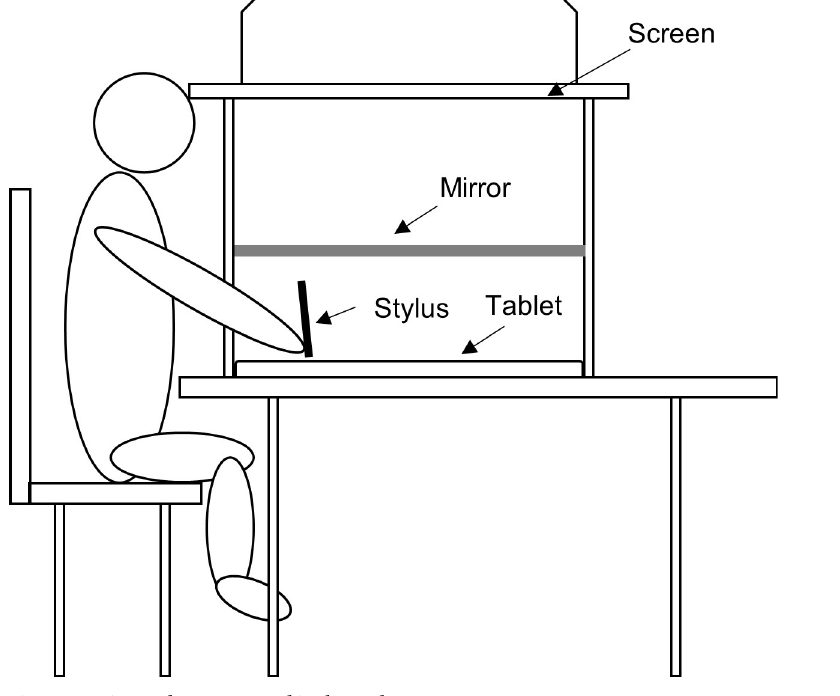
Fig 1. Experimental set-up as used in the